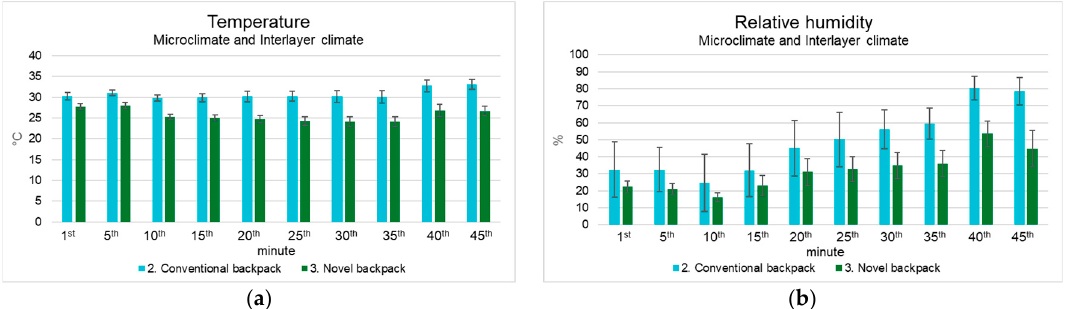
Figure 3. The overall mean results from all temperature ( a ) and humidity ( b ) sensors placed in the microclimate and interlayer climate for the two test conditions using different backpacks. Mean ±